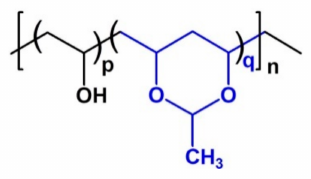
Figure 1. PVA-Ac copolymer structure.